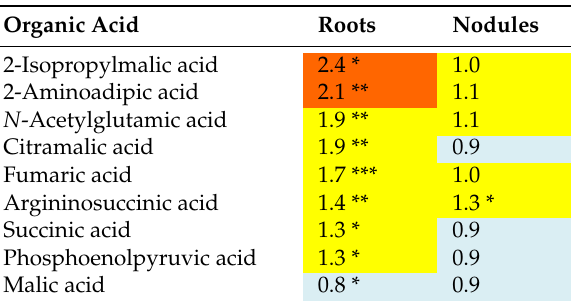
Table 3. Comparison of the ratios of concentrations of organic acids in soybean roots and nodules treated with 5 mM of nitrate for 24 h and the control